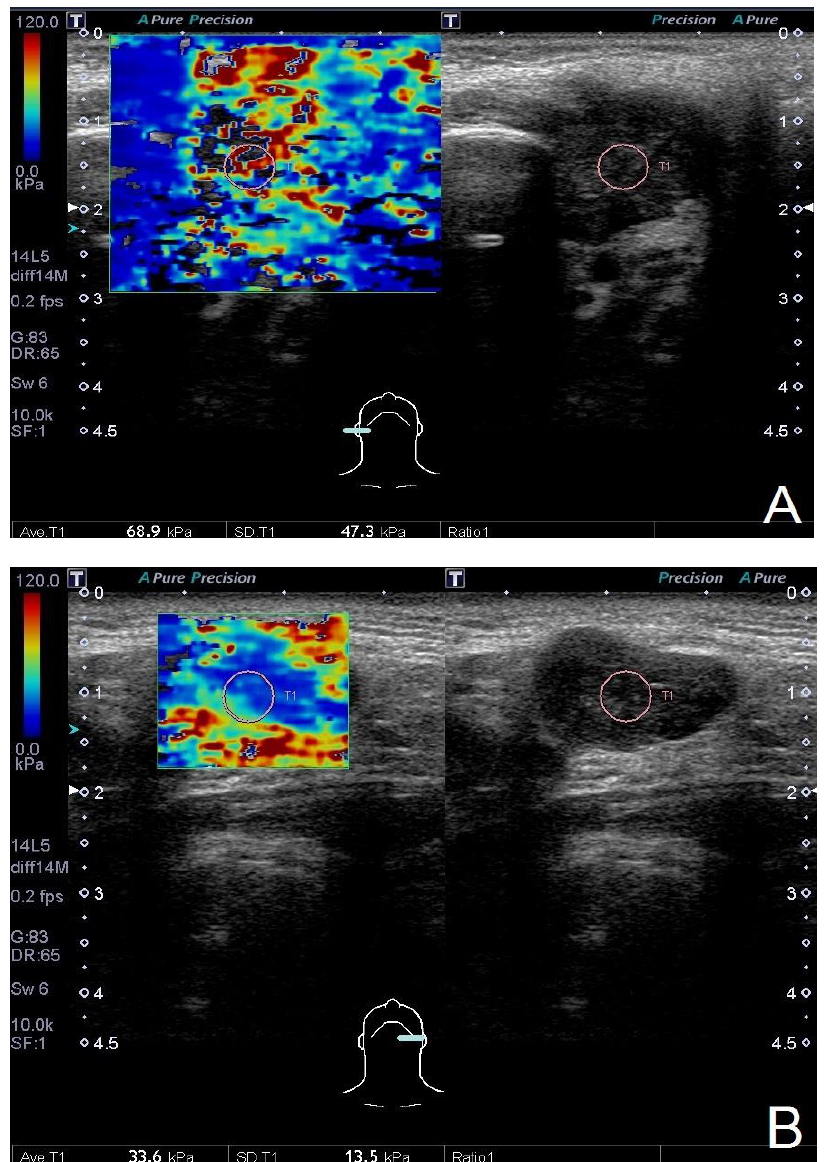
Figure 1. The measurement of shear wave elastography with a 5-mm circular region of interest. Note. ( A ) A 21-year-old female had a right parotid tumor for several months. The average and standard deviation of elasticity were 68.9 kPa and 47.3 kPa, respectively. The pathological report showed mucoepidermoid carcinoma. ( B ) A 59-year-old male had a left parotid tumor for several months. The average and standard deviation of elasticity were 33.6 kPa and 13.5 kPa, respectively. The pathological report showed Warthin’s